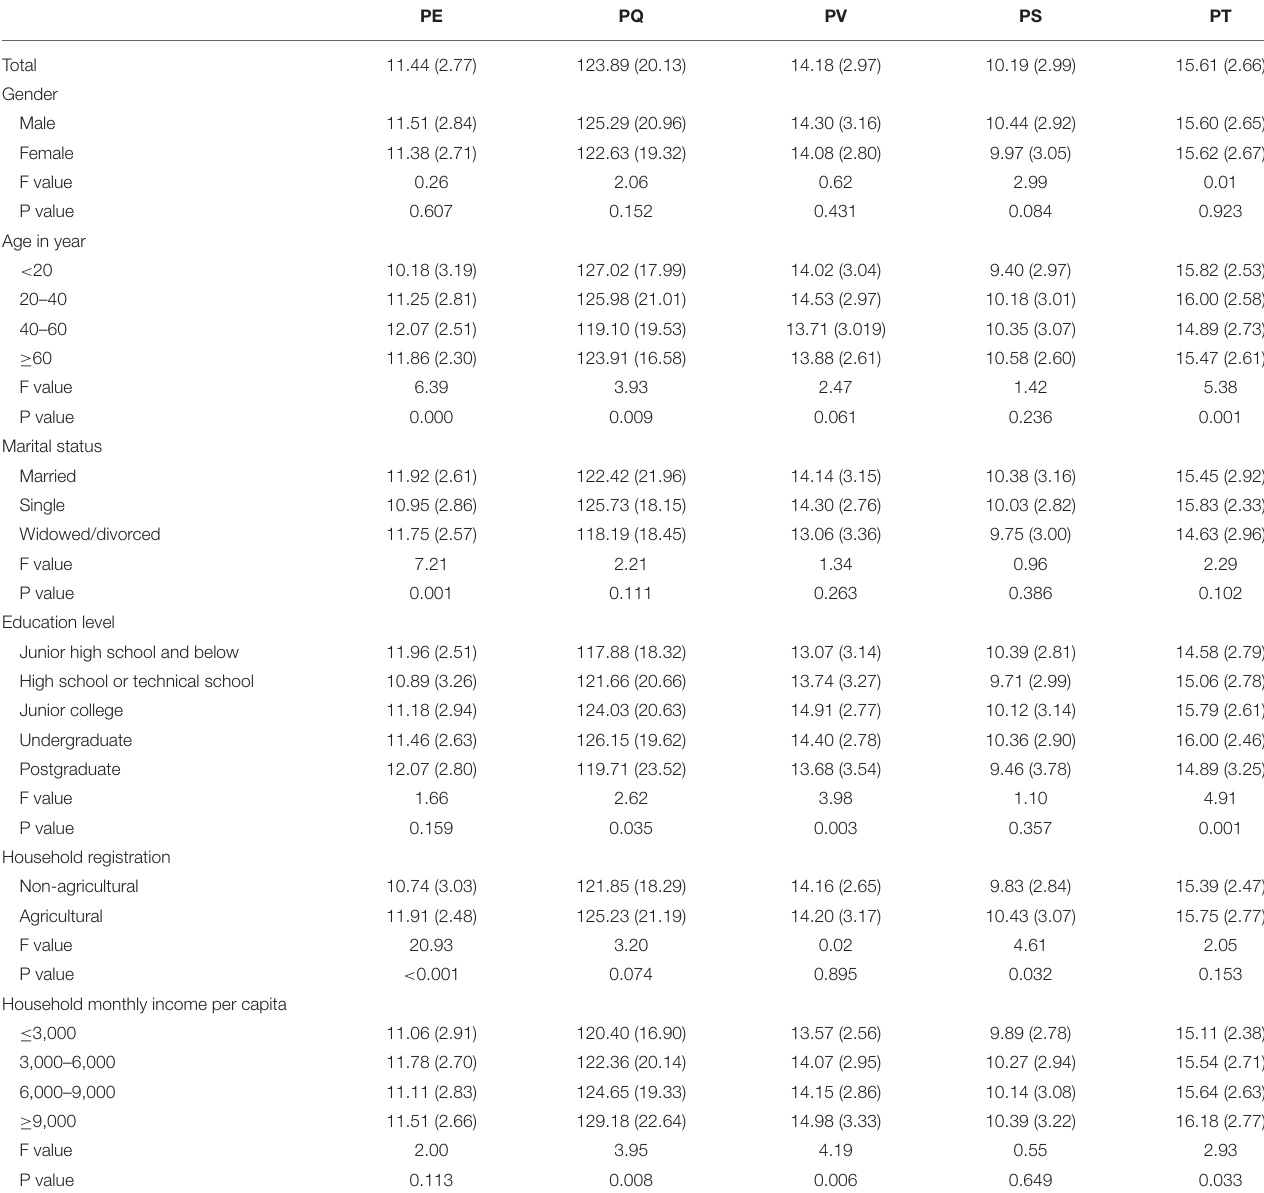
TABLE 3 | The scores of five dimensions of satisfaction with health education by characteristics (M, SD).